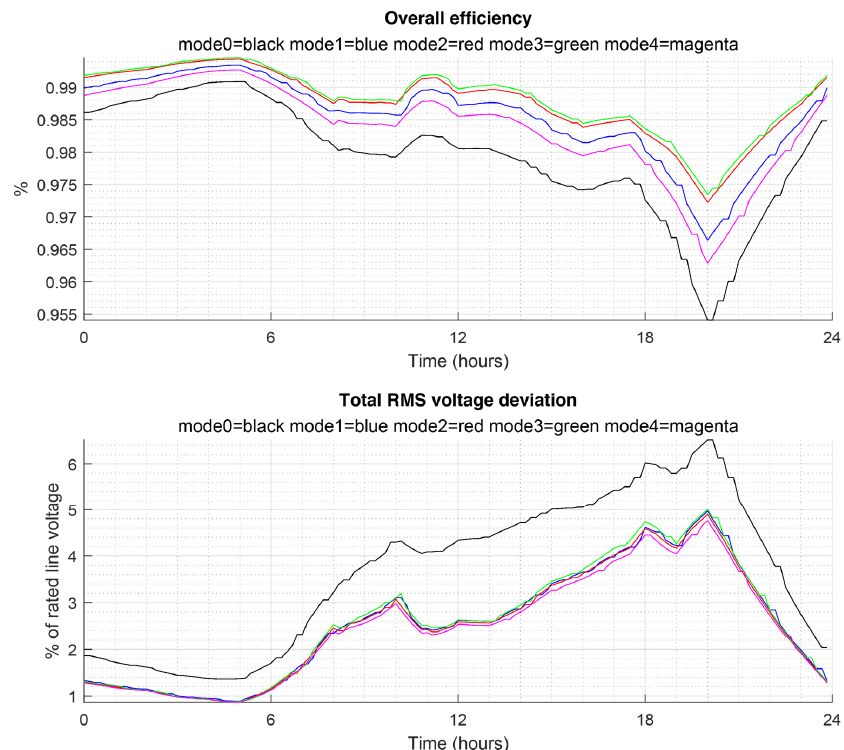
Figure 10. Effect of control methods on the overall efficiency and RMS voltage deviations, as in Figure 7, but with the UI driven by central control. Voltage deviation factor is unaffected, overall efficiency is improved.